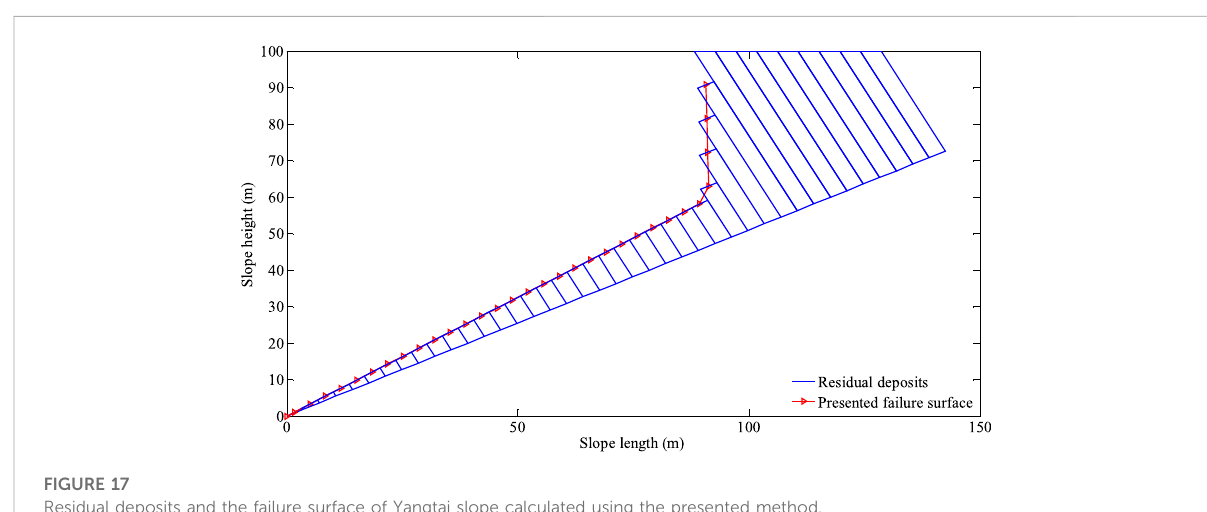
FIGURE 17 Residual deposits and the failure surface of Yangtai slope calculated using the presented method.